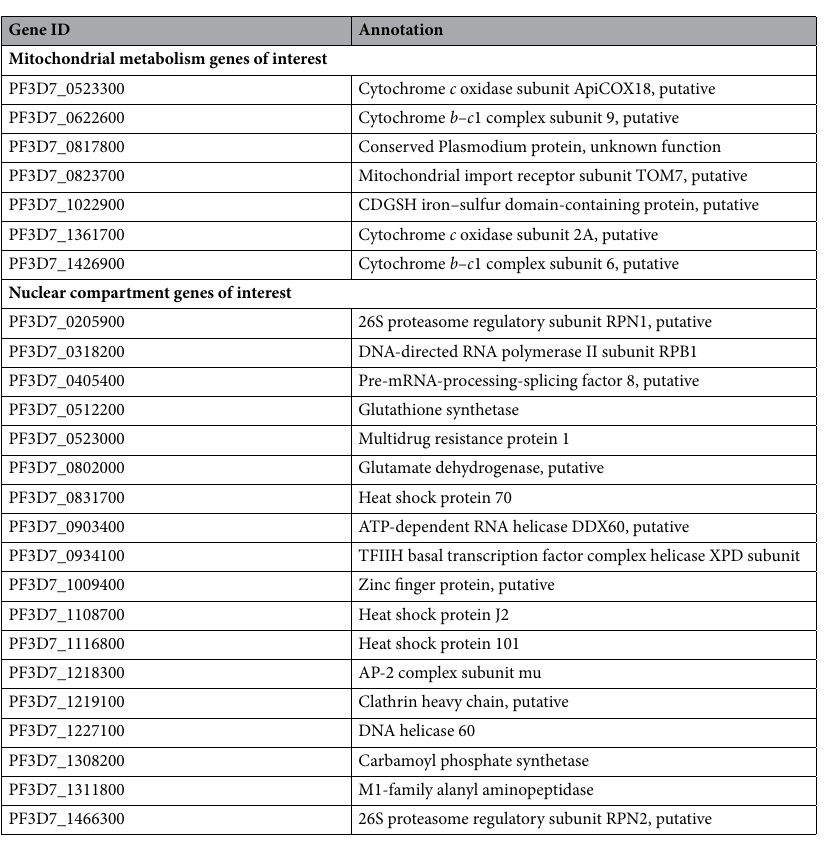
Table 1. Top differentially expressed genes associated with mitochondrial and nuclear metabolism gene ontologies in the KIC5 mutant (Supplementary Table